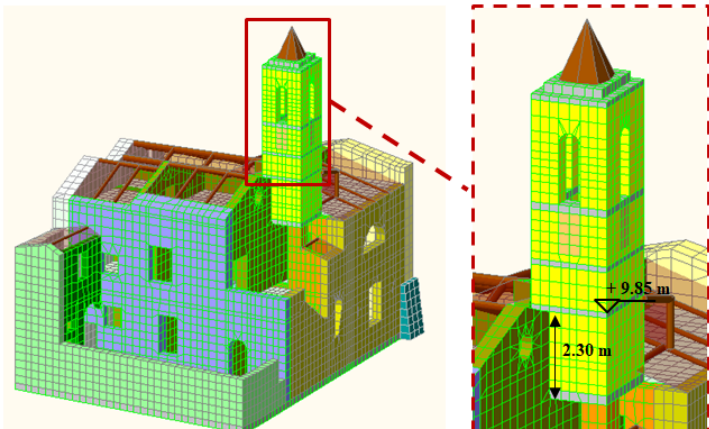
Figure 5. The bell tower of S. Anna in Cervino.